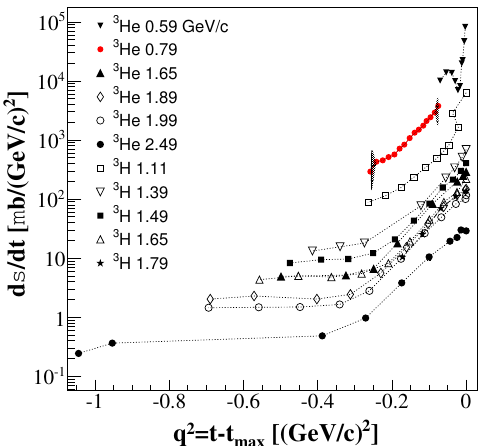
Figure 3: (Color online) Left panel: Diffferential, but integrated over S , cross section presented as a function of the relative azimuthal angle ϕ bination as indicated in the panel. The data points are compared with the results of calculations based on pure CD Bonn, Argonne V18 and CD Bonn + ∆ potentials for 1-term ( 1t ) and 4-term ( 4t ), as described in the legend. The boxes around the experimental points represent the total systematic errors. Right panel: Quality of the description of the cross-section data with various theoretical predictions (defined in the legend), expressed as a dependence of the A -factor on the neutron energy E The bin size was chosen to be ± 2 MeV. Lines connecting points are used to guide the eye. For details see also Refs. [ 37,38 ] .